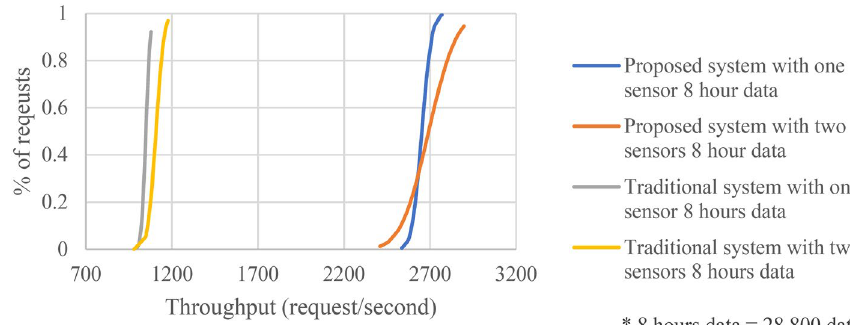
Fig. 7 Box plot chart of throughput evaluation